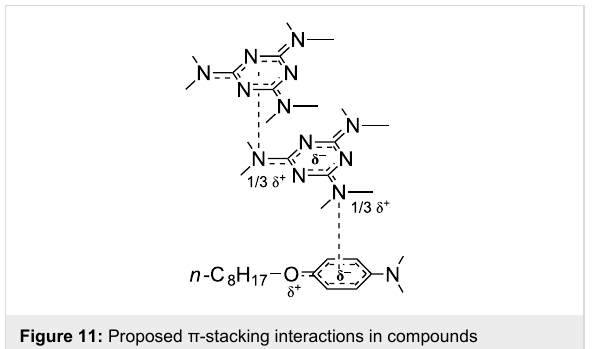
Figure 11: Proposed π -stacking interactions in compounds D-N<P>NH and 5 – 7a .